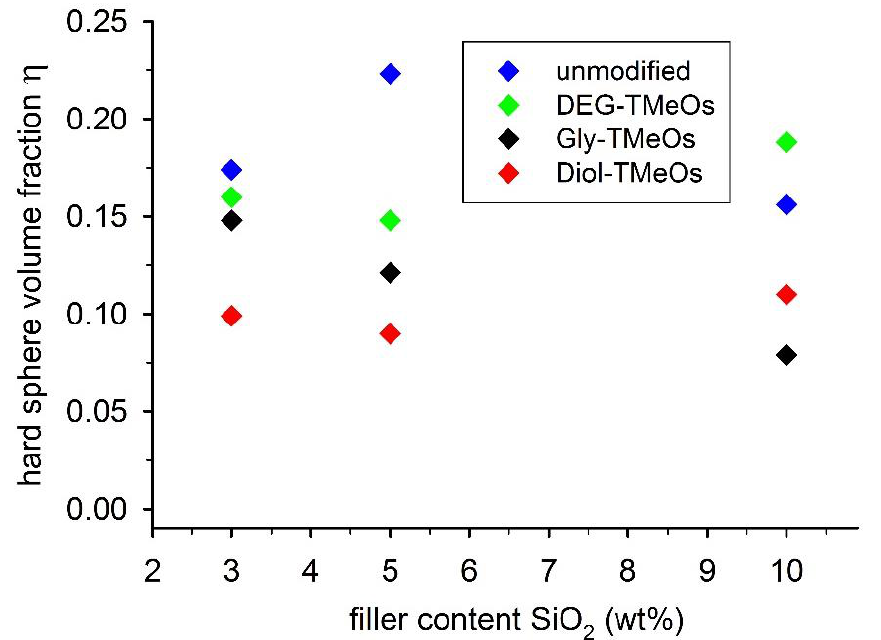
Figure 8. Hard sphere volume fraction of small SiO 2 nanoparticles with different surface modifications and incorporated into the epoxy resin matrix with different percentages.